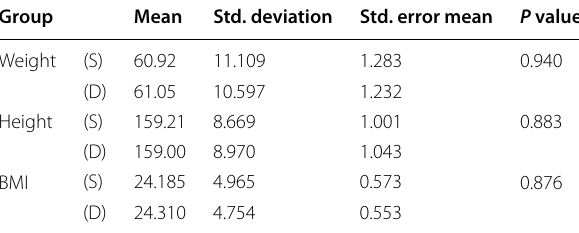
Table 1 Demographic